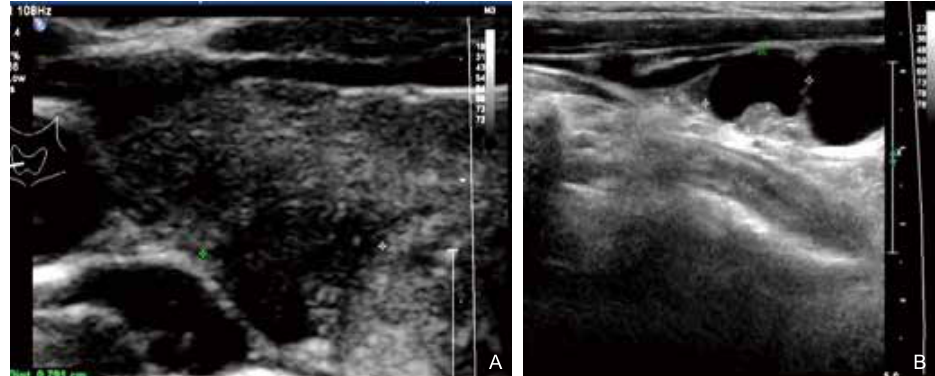
Figure 5 (A) PTMC showing the anteroposterior diameter >0.7 cm, microcalcification and tumor located in the upper pole. (B) LLNM showing loss of fatty hilum and cystic change of lymph